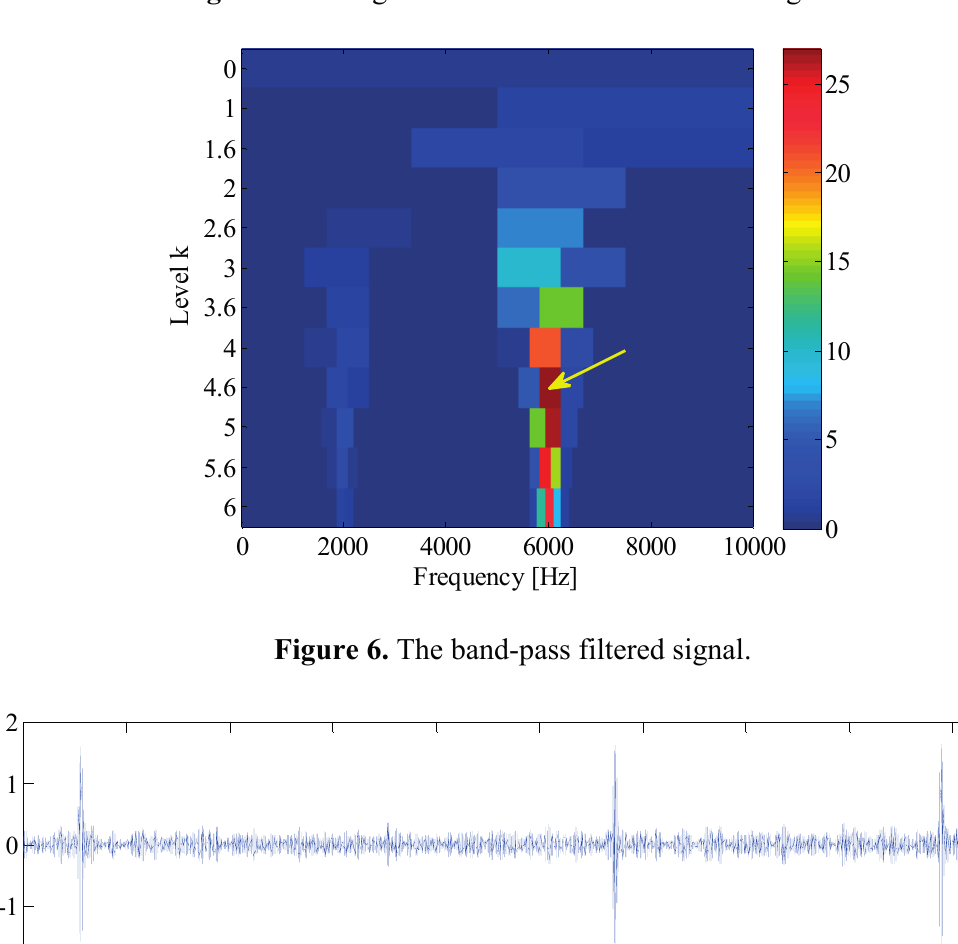
Figure 5. Kurtogram of simulated out-race fault signal.